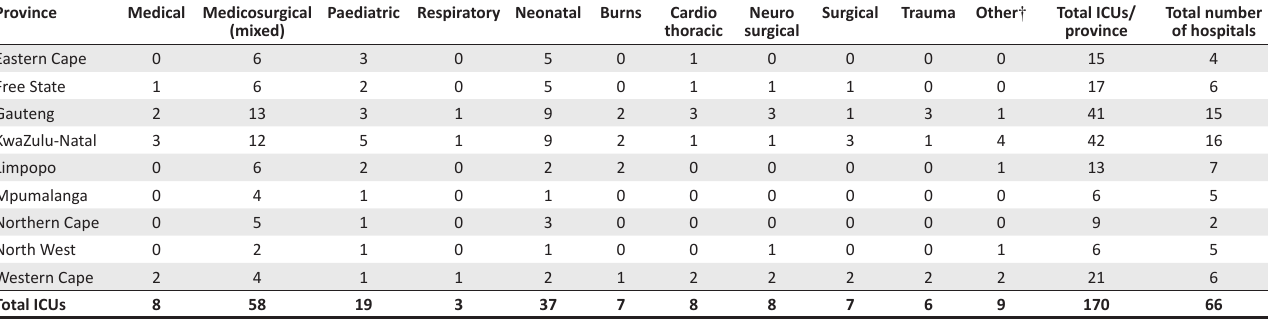
TABLE 1: Distribution of intensive care units and hospitals across the nine provinces. Province